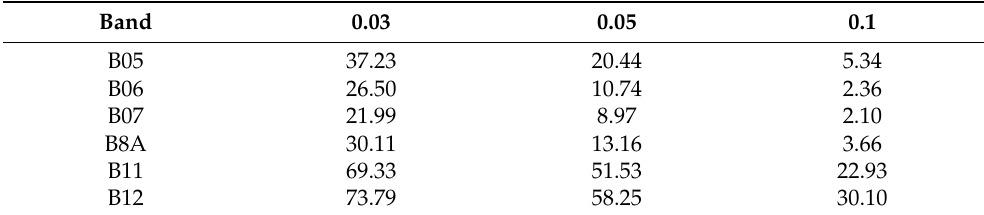
Table 7. Percentage of pixels beyond a given relative error threshold (L1C).